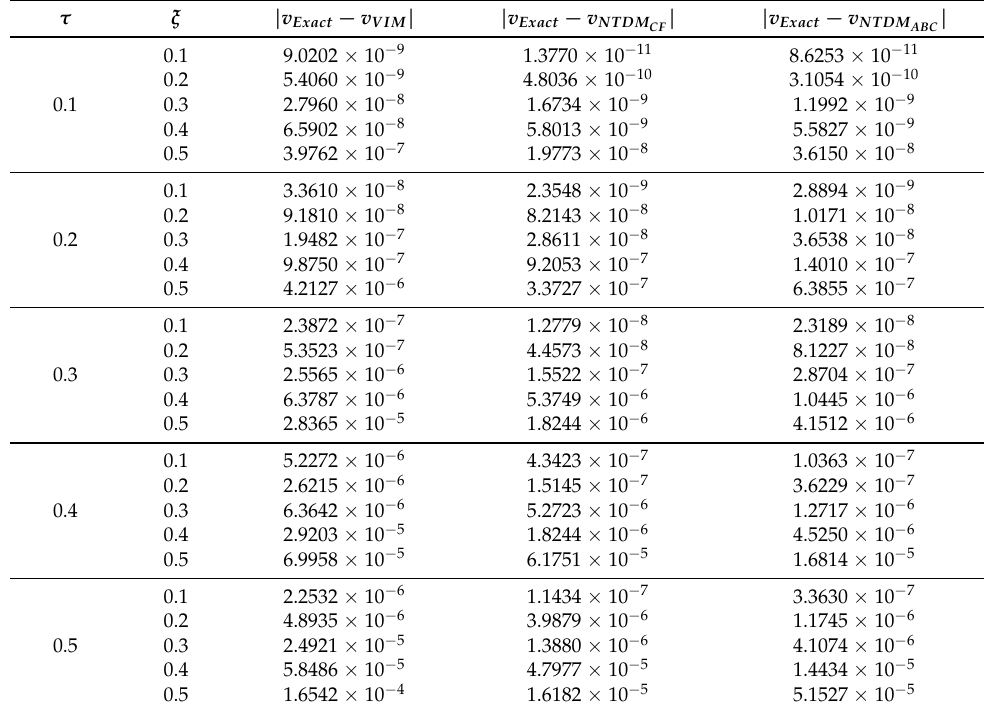
Table 3. Comparative study between VIM [34], NTDM CF and NTDM ABC for the approximate solution v ( ξ , ζ , τ ) of Example 1 at Re = 100, ζ = 1, α = 1, and β = 1 for l = 4.